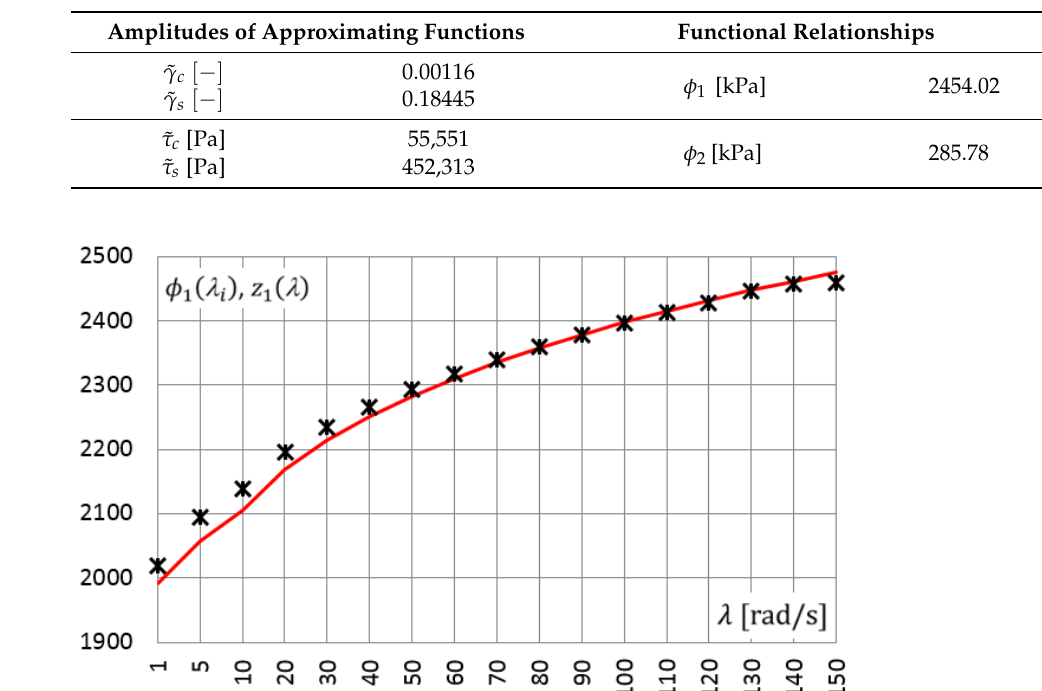
Table 2. Approximation results given for the stress-strain relationship ( λ = 140 rad/s).